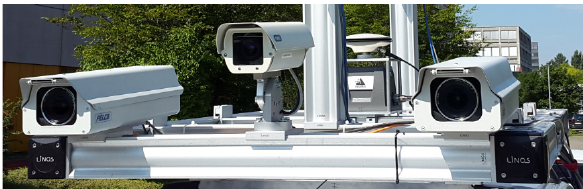
Figure 1. Sensor configuration of the IVGI mobile